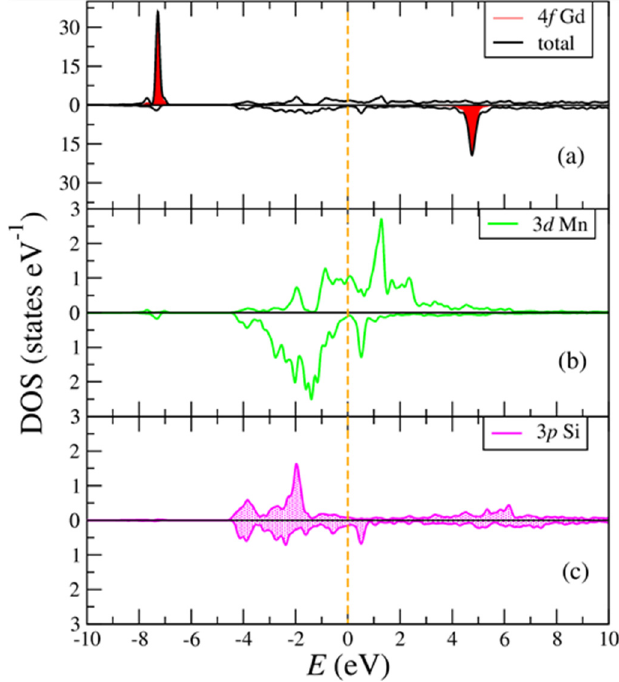
Figure 3. The density of states of GdMnSi per formula unit. ( a ) Total and partial Gd-4f densities of states; ( b ) partial density of states for Mn-3d; ( c ) partial density of states for Si-3p. The Fermi level is a dashed vertical line.